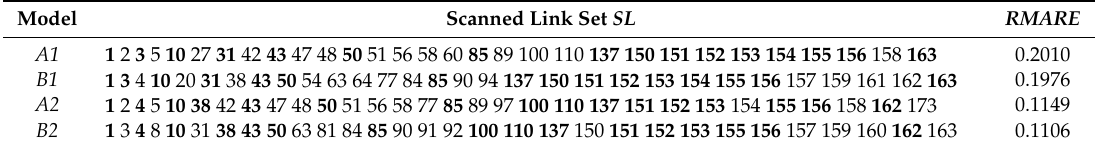
Table 4. Best set of links ( 𝑆𝐿 ) sets obtained from the variability analysis of 𝑘 parameter.